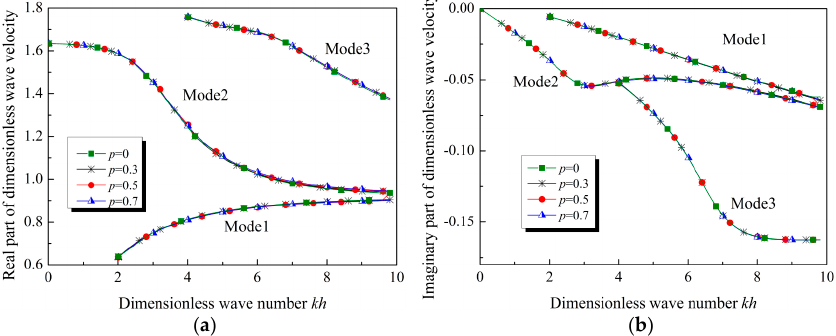
Figure 6. Wave velocity of Lamb waves in homogenous viscoelastic film and in FGVM film (with all material parameters varying linearly and identically). ( a ) Real part, ( b ) imaginary part.